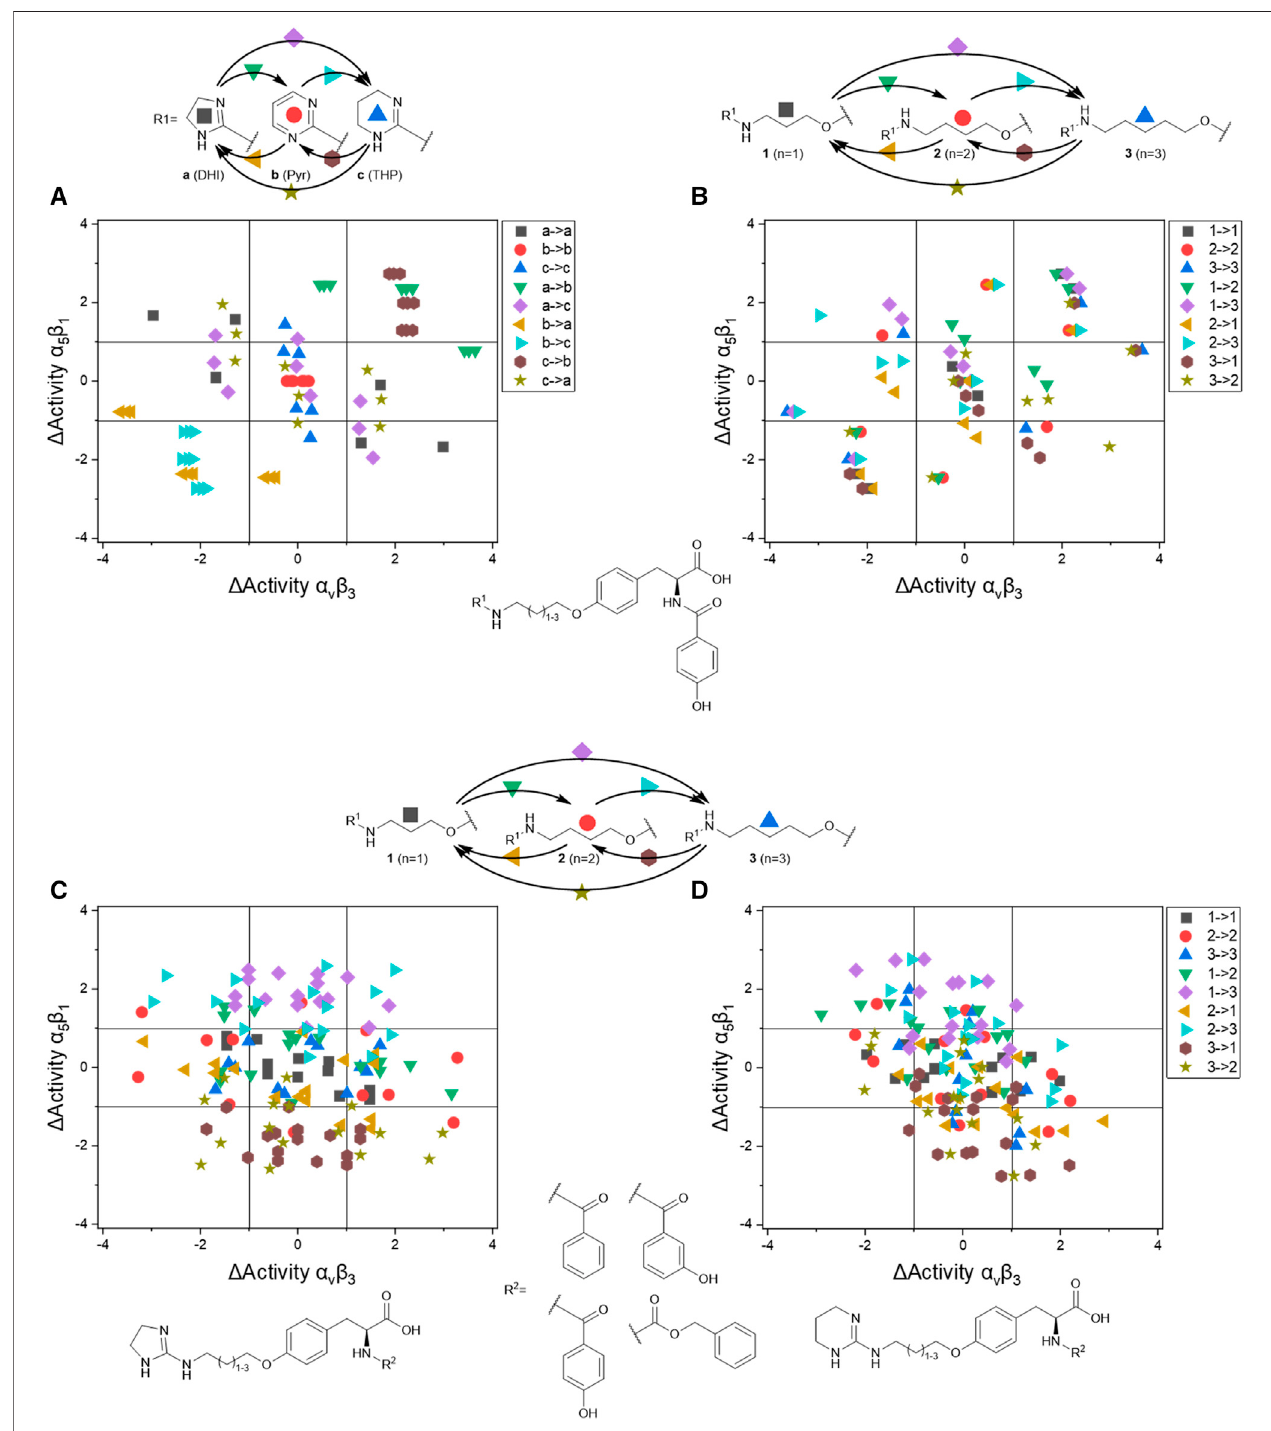
FIGURE 8 | Selected DAD maps of the RGD mimetic array ( Table 4 ), the completing maps are shown in the supplementary material ( Supplementary Figures S2 – S5 ). (A – B) In fl uence of variations of the guanidino mimetic (A) and linker length (B) with the underlying structure shown below the panels. C relates to the guanidino mimeticDHI,whilethecommonelementin (D) istheguanidinomimeticTHP.InbothCandD,thein fl uenceofthelinkerlengthisdisplayed,andtherelatedleadstructure is shown below the panels. The structural change in the aromatic moiety ( R 2 ) is not highlighted in (C – D) . As displayed in Figure 7 , signals in the upper-left (high af fi nity and selectivity for integrin α V β 3 ) and the lower-right (highaf fi nity and selectivity for integrin α 5 β 1 ) corner indicate structuralchangeswhich leadto higher af fi nity and selectivity.